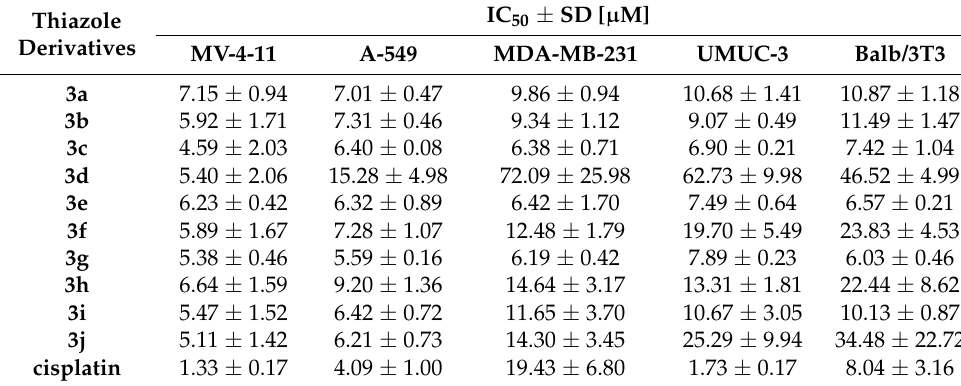
Table 3. Antiproliferative activity of thiazoles 3a – 3j against human biphenotypic B